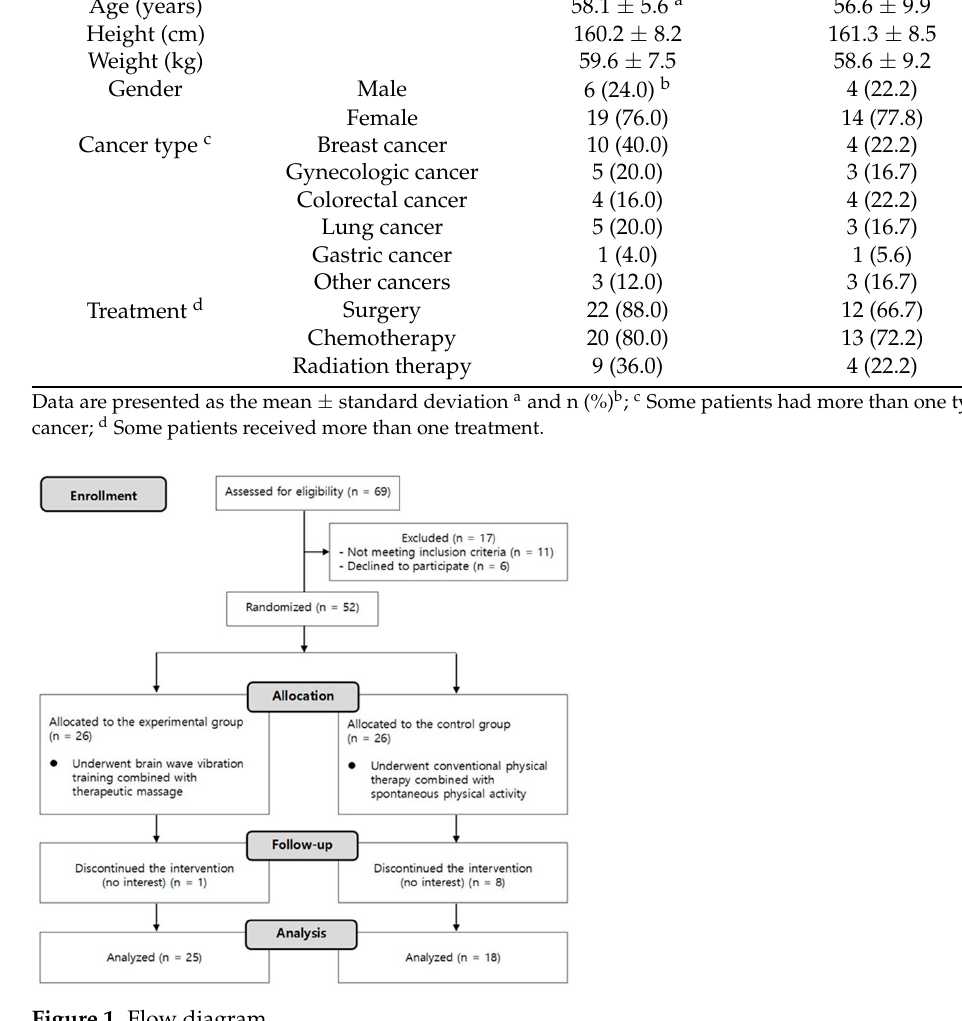
Figure 1. Flow diagram.